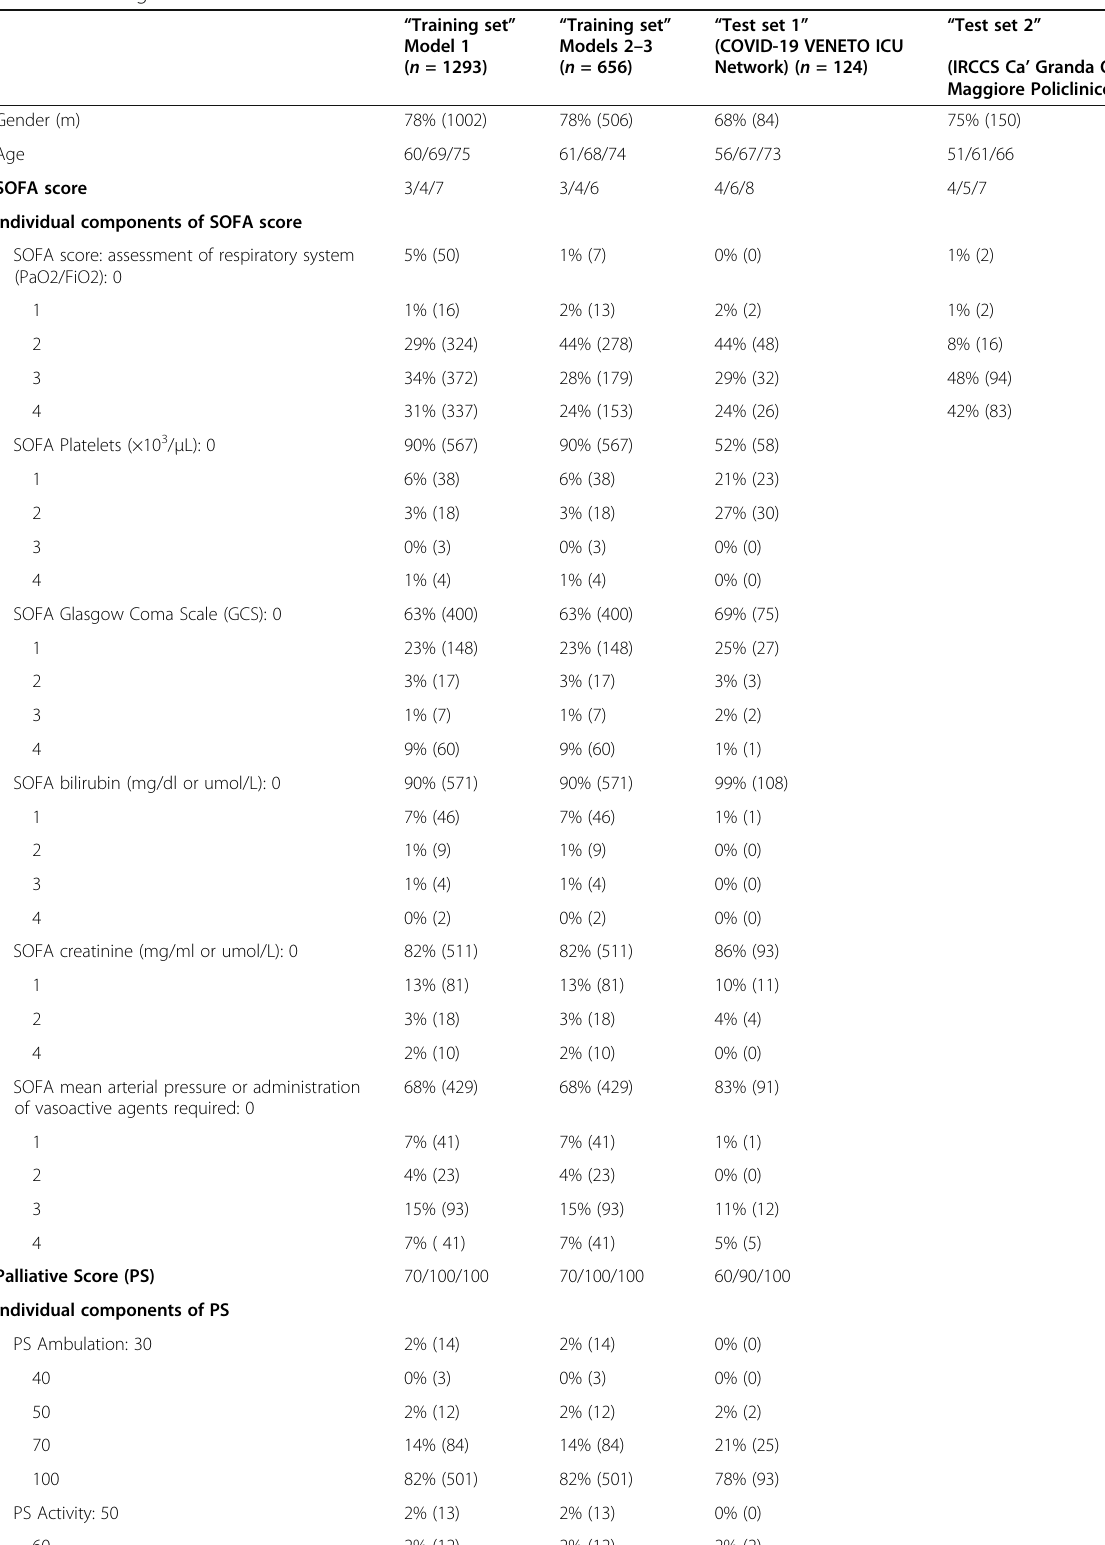
Table 1 Training and test sets